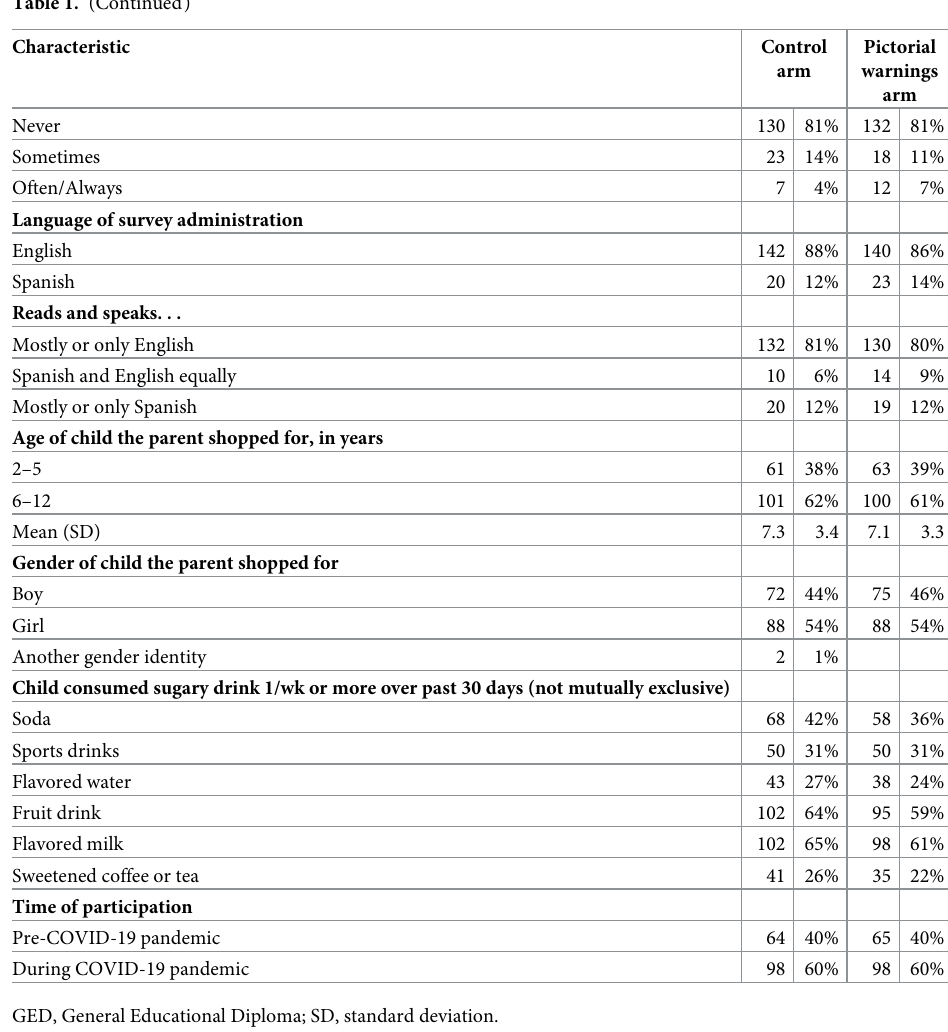
Nearly three-quarters (73%) of parents in the pictorial warnings arm reported the label made them feel more in control of healthy eating decisions, compared with 30% in the control arm ( p < 0.001; Table 2 ). Exposure to pictorial warnings on sugary drinks also led to stronger label reactions, including greater thinking about the harms of sugary drinks ( d = 2.08, p < 0.001), greater negative emotional reactions ( d = 1.91, p < 0.001), and greater anticipated social interactions ( d = 1.35, p < 0.001). Pictorial warnings changed several sugary drink atti- tudes and intentions, including lower perceived healthfulness of sugary drinks for their child ( d = − 0.32, p = 0.004), greater injunctive norms to limit sugary drinks for their child ( d = 0.31, p = 0.006), and lower intentions to serve sugary drinks to their child ( d = − 0.26, p = 0.022). Pic- torial warnings did not lead to differences in noticing of the label ( p = 0.373), appeal of sugary drinks for child ( p = 0.439), perceived amount of added sugar in sugary drinks ( p = 0.220), per- ceived tastiness of sugary drinks to their child ( p = 0.104), or perceived likelihood of child experiencing health problems due to sugary drinks ( p =